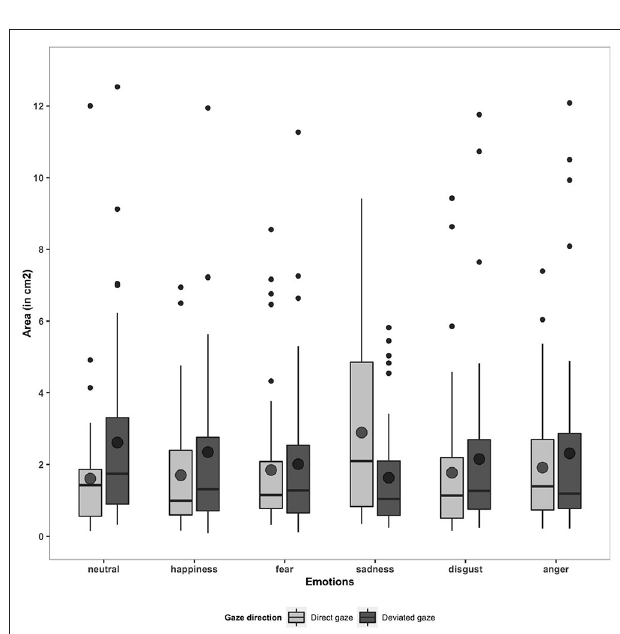
FIGURE 4 | Boxplots and means for Area (in cm 2 ) in response to six emotions (neutral, happiness, fear, sadness, disgust, and anger) and two gaze directions (direct and